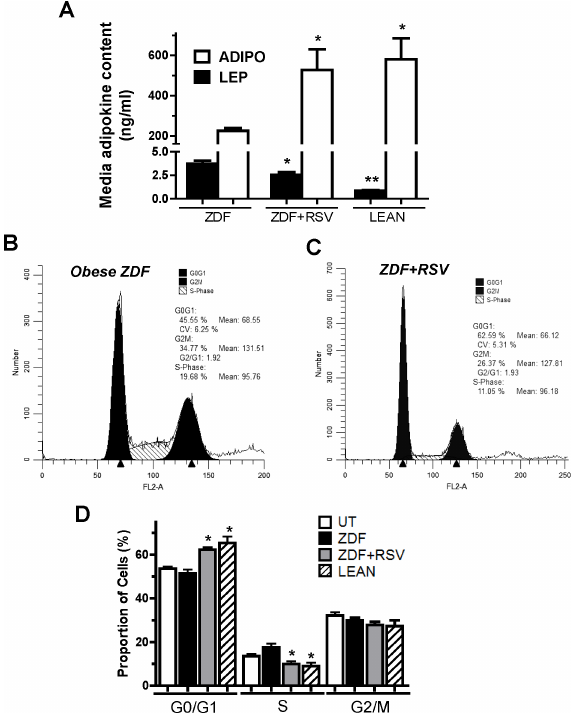
Fig 4. ZDF+RSV-CM supplementation causes cell cycle exit in MCF7 cells compared to ZDF-CM. A: Graphicalrepresentation of ADIPO and LEP concentration (ng/ml) in conditioned media (CM) created from scAT. B-C: Typical cell cycle profiles in MCF7 cells grown in CM preparedfrom scAT of ZDF or ZDF+RSV supplemented rats. D: Graphicalrepresentation of multiplecell cycle profile experiments observingeffects of ZDF-CM (closedbars), ZDF+RSV-CM (grey bars) and lean Zucker (hatchedbars) in proliferating MCF7 cells. * denotessignificantly different from ZDF (p < 0.05)as determined by Tukey’s post-hoc tests (p < 0.05,n = 5-6/